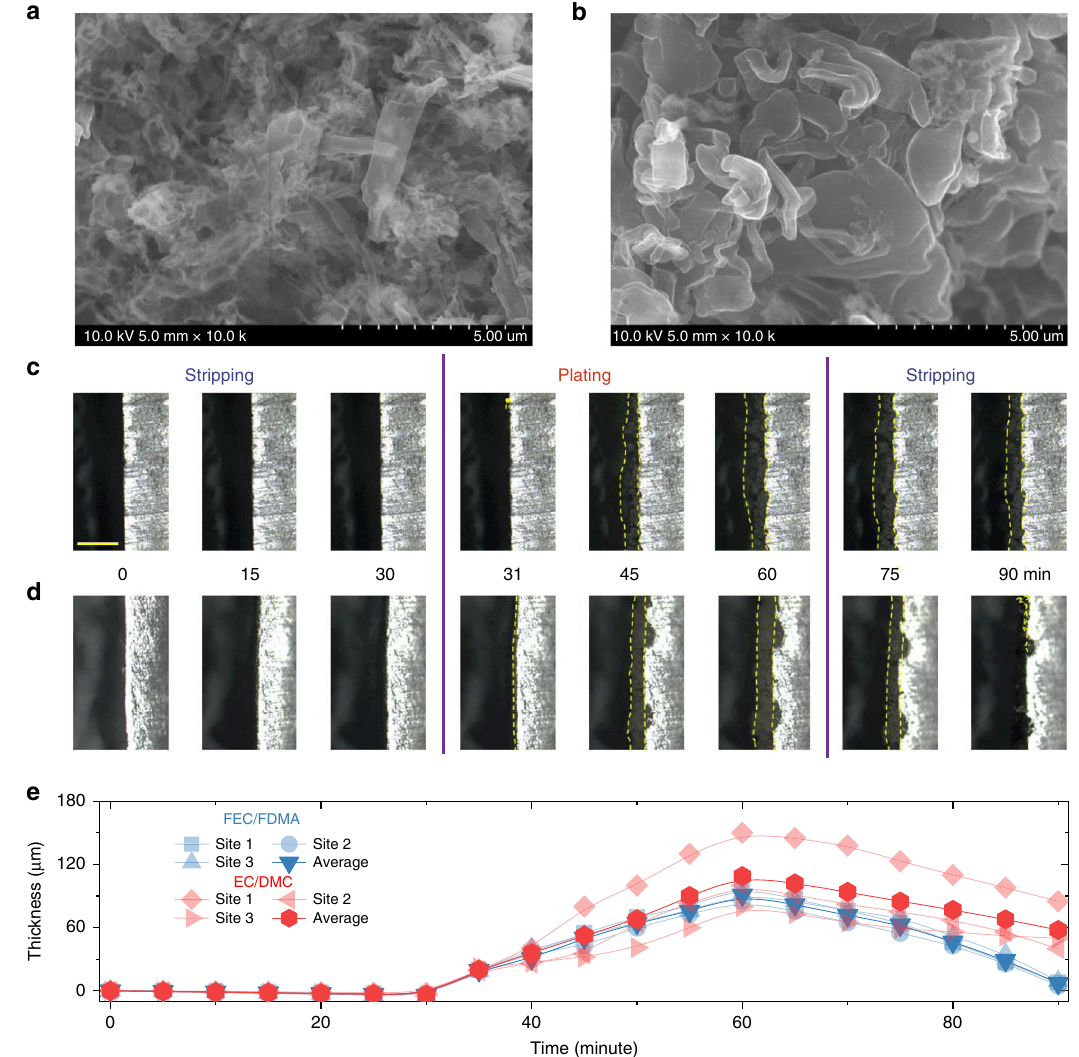
Fig. 3 Characterization of morphology during Li + plating/stripping. a , b Scanning electron microscopy (SEM) images after Li plating at current density of 1 mA cm − 2 to the capacity of 1 mAh cm − 2 on a Cu substrate in 1 M LiPF 6 -EC/DMC and 1 M LiTFSI-FEC/FDMA. c , d In situ optical microscopy images showing the cross-section of Li electrode upon plating/stripping in a symmetric cell at 1 mA cm − 2 , recorded at the speci fi ed plating/stripping stage in a 1 M LiPF 6 -EC/DMC and 1 M LiTFSI-FEC/FDMA electrolytes. The scale bar for c , d is 200 μ m. e The evolution of thickness for the deposition of during Li plating/stripping. Three locations, at 1/4, 1/2, and 3/4 along the Li-metal foil are chosen to measure the change in thickness, from which the average thickness is